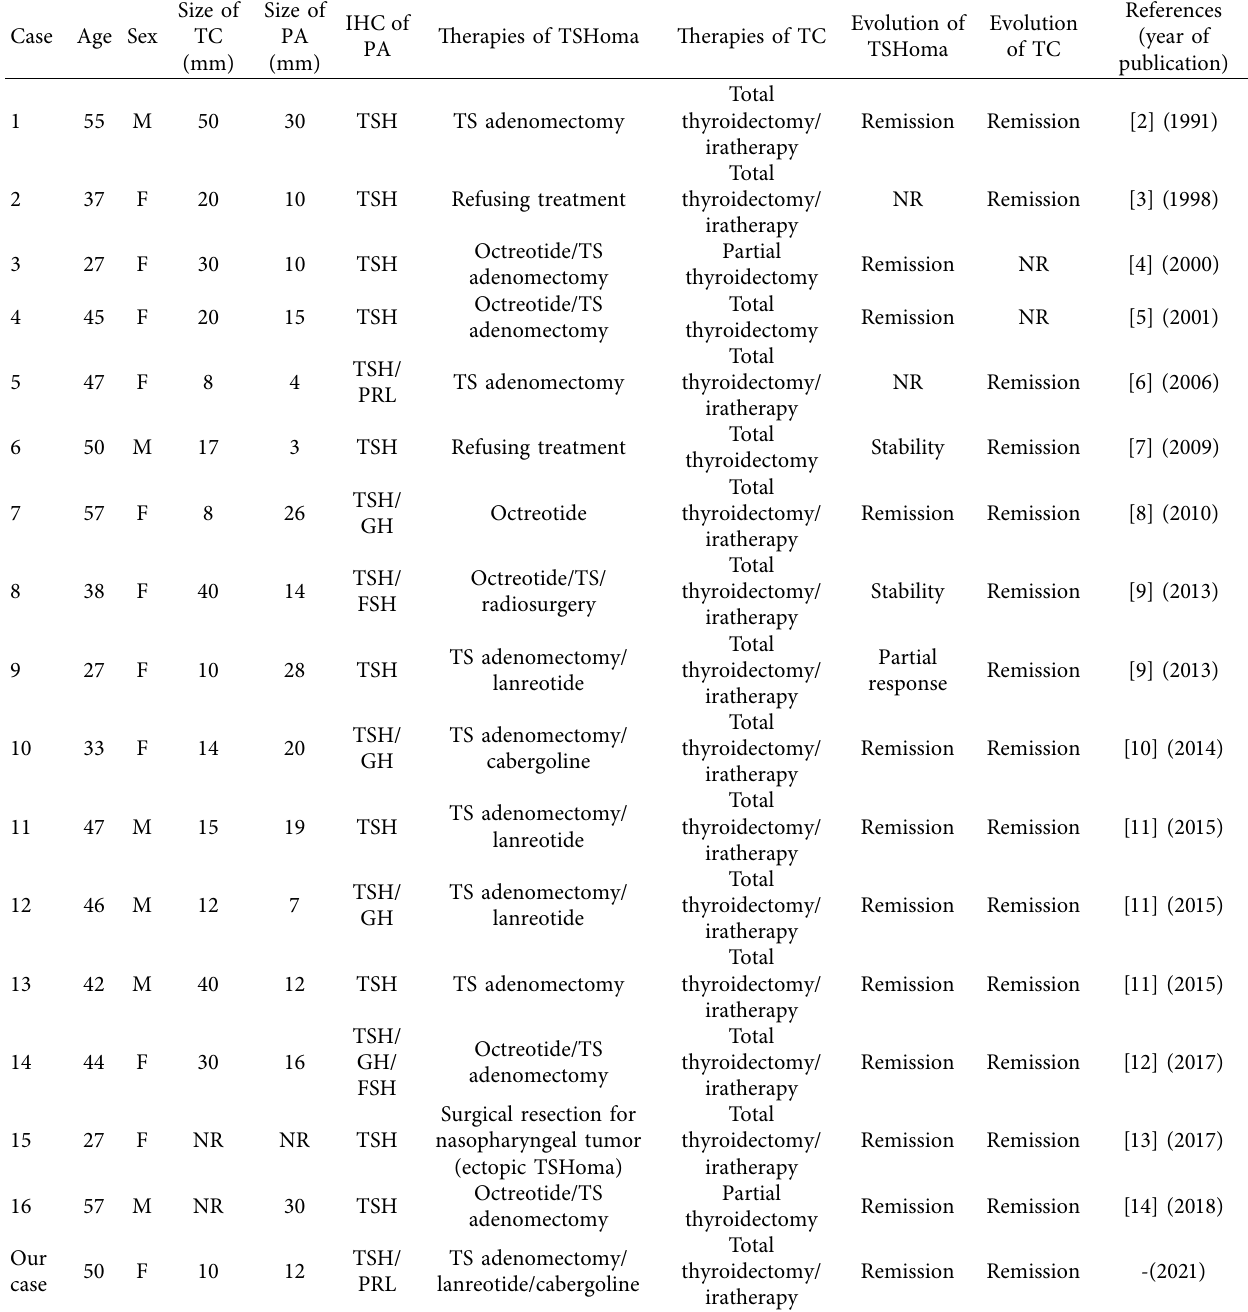
Table 2: Literature review of thyroid cancer with